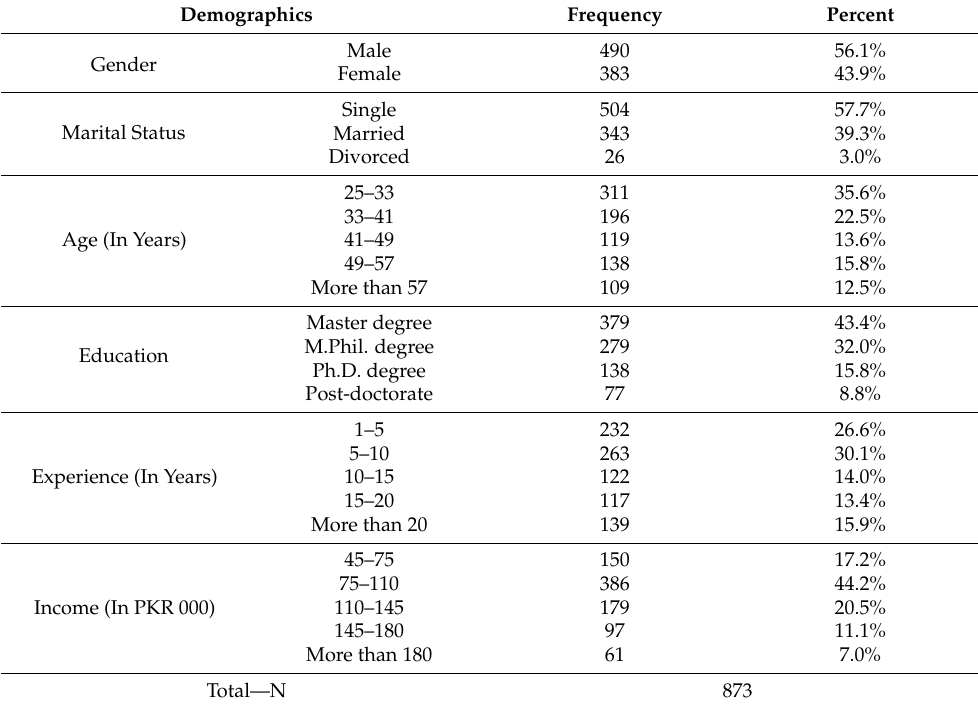
Table 1. Demographic analyses.